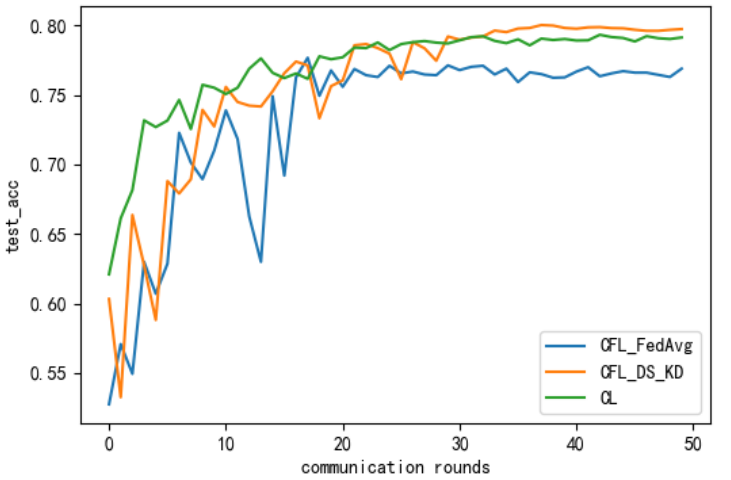
Figure 8. The accuracy of the different methods on the testing set after different amounts of commu- nication rounds.